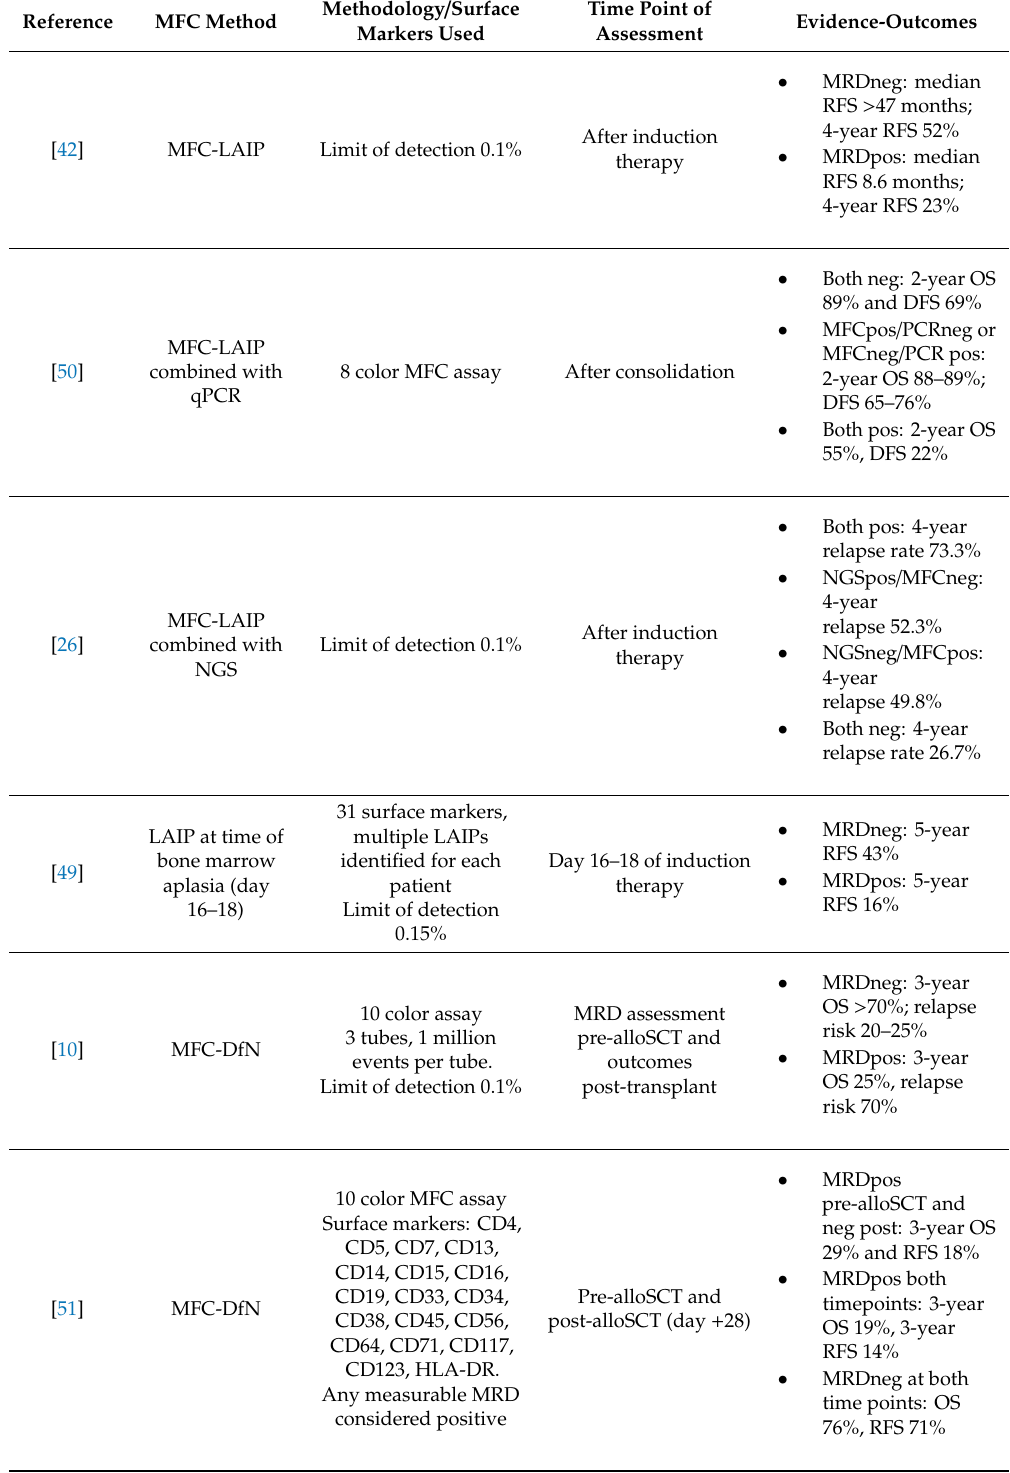
Table 2. Comparison of strategies used for MRD detection using multiparametric flow cytometry (MFC) and their clinical